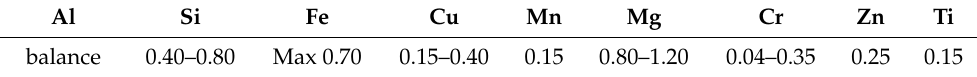
Table 1. Chemical composition of the 6061-O aluminum alloy (wt.%).